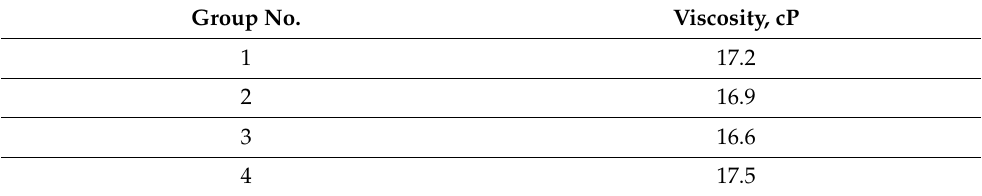
Table 1. Viscosity of the coal slurry. Group No.